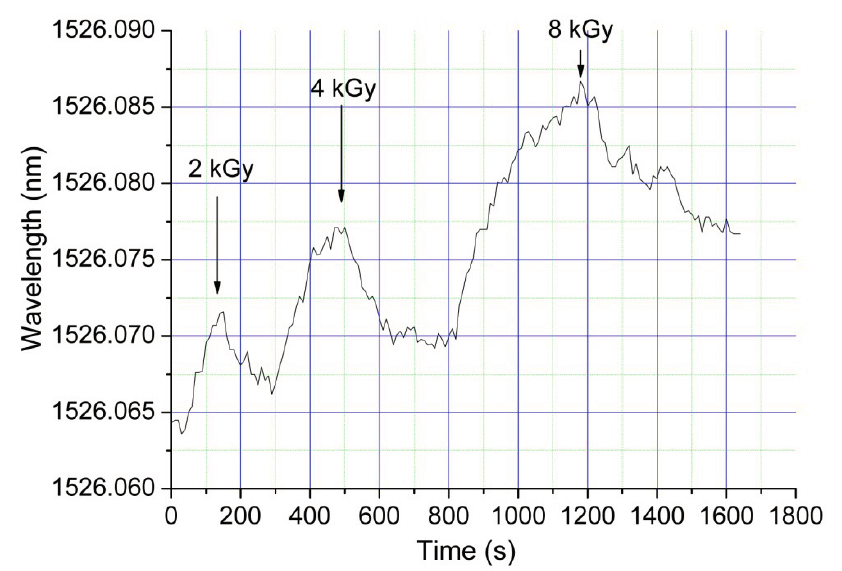
Figure 2. The effect of the bias during the wavelength reading, after subsequent exposure of the same sensor to different doses, in the case of natural cooling by